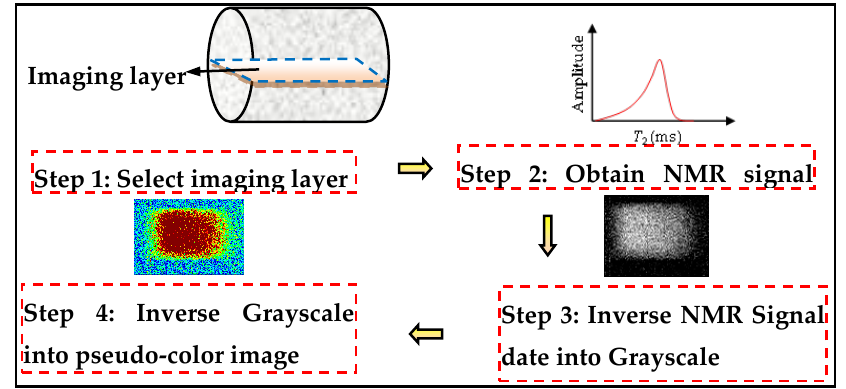
Figure 8. MRI process.